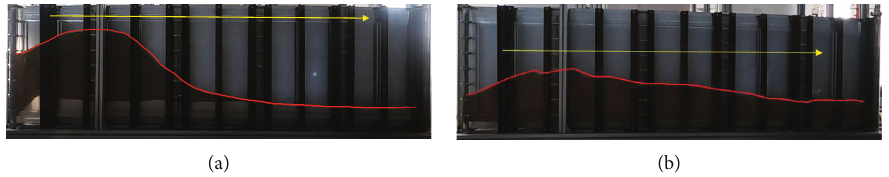
Figure 10: Con fi guration of 20/40 mesh quartz sand with di ff erent fracturing fl uid viscosities: (a) viscosity of 3 mPa s and (b) viscosity of 5mPa